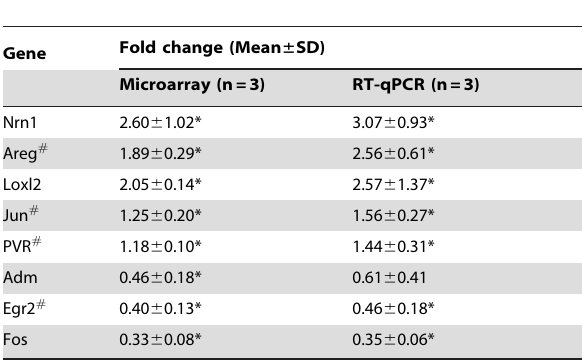
Table 7. Validation of Microarray Gene Expression at 24 h by